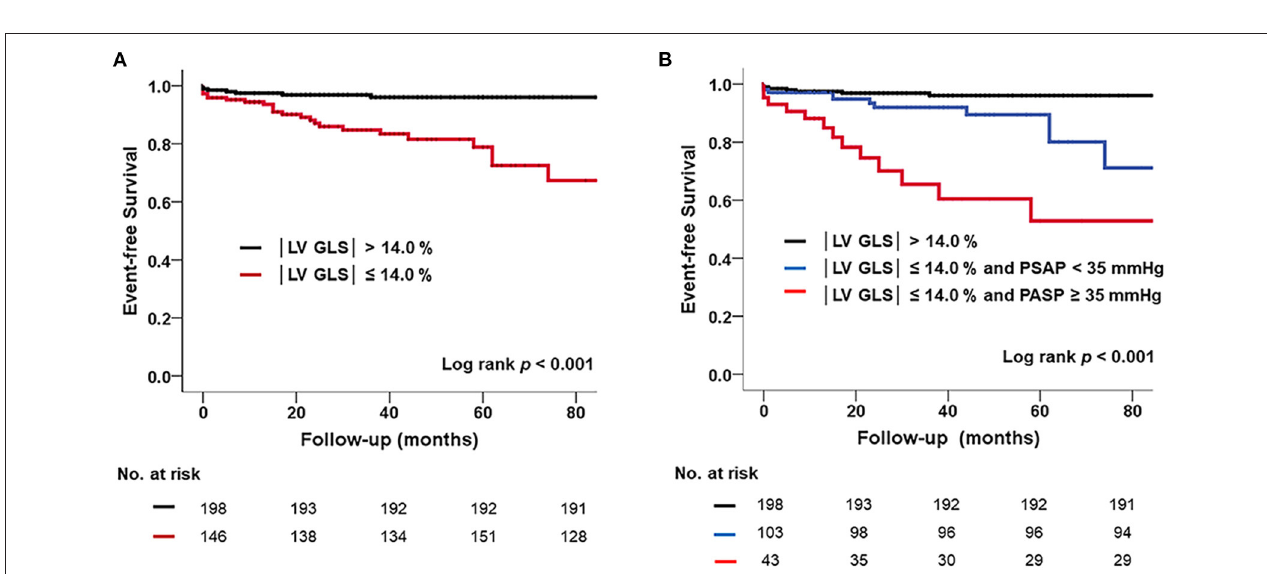
FIGURE 3 | (A) Kaplan–Meier survival curve showing poor prognosis in subjects with reduced |LV-GLS| compared those without. (B) Poorer outcomes in subjects with reduced |LV-GLS| and pulmonary hypertension. |LV-GLS|, the absolute value of left ventricular longitudinal strain.